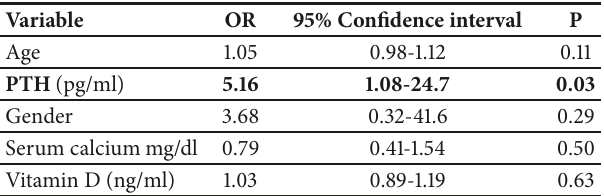
Table 3: Multivariate analysis of features potentially associated with thyroid